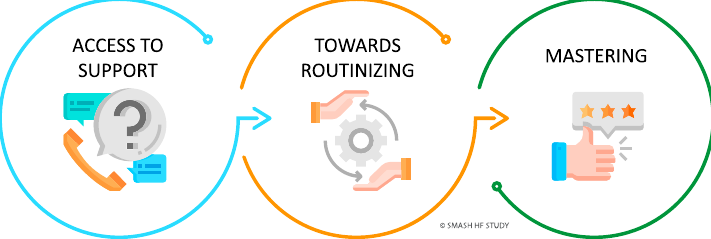
Figure 2. Informal caregivers’ process of access to support, towards routinizing, and mastering performing telemonitoring to support the person with heart failure.